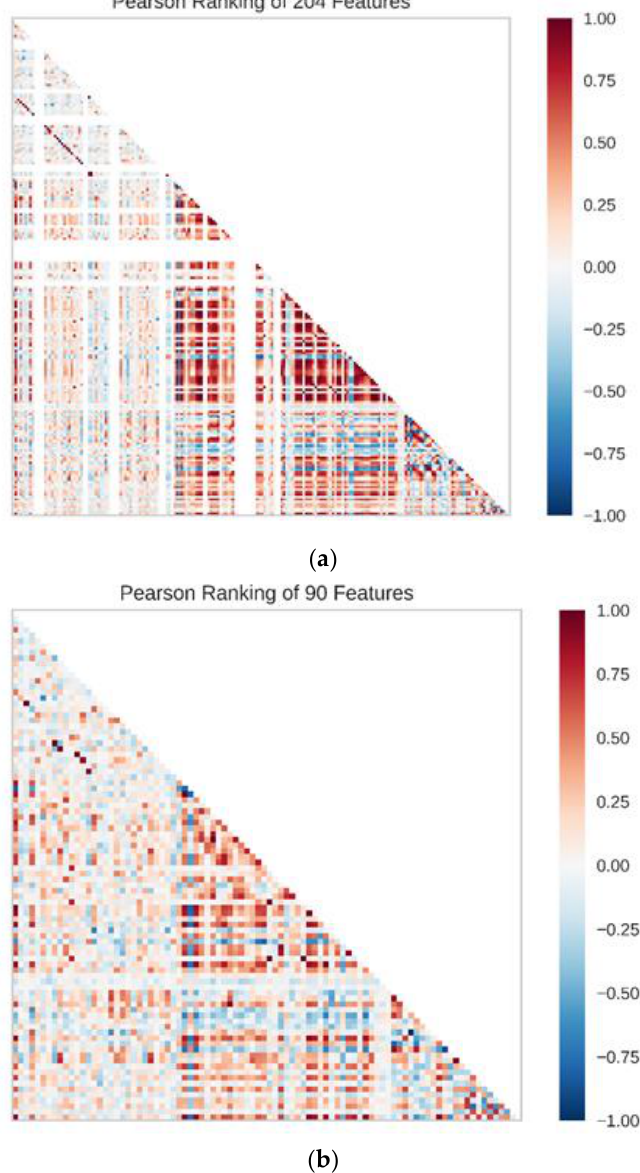
Figure 11. ( a ) Result of the Pearson correlation coefficient of 204 features; ( b ) 90 features with small correlation coefficients.